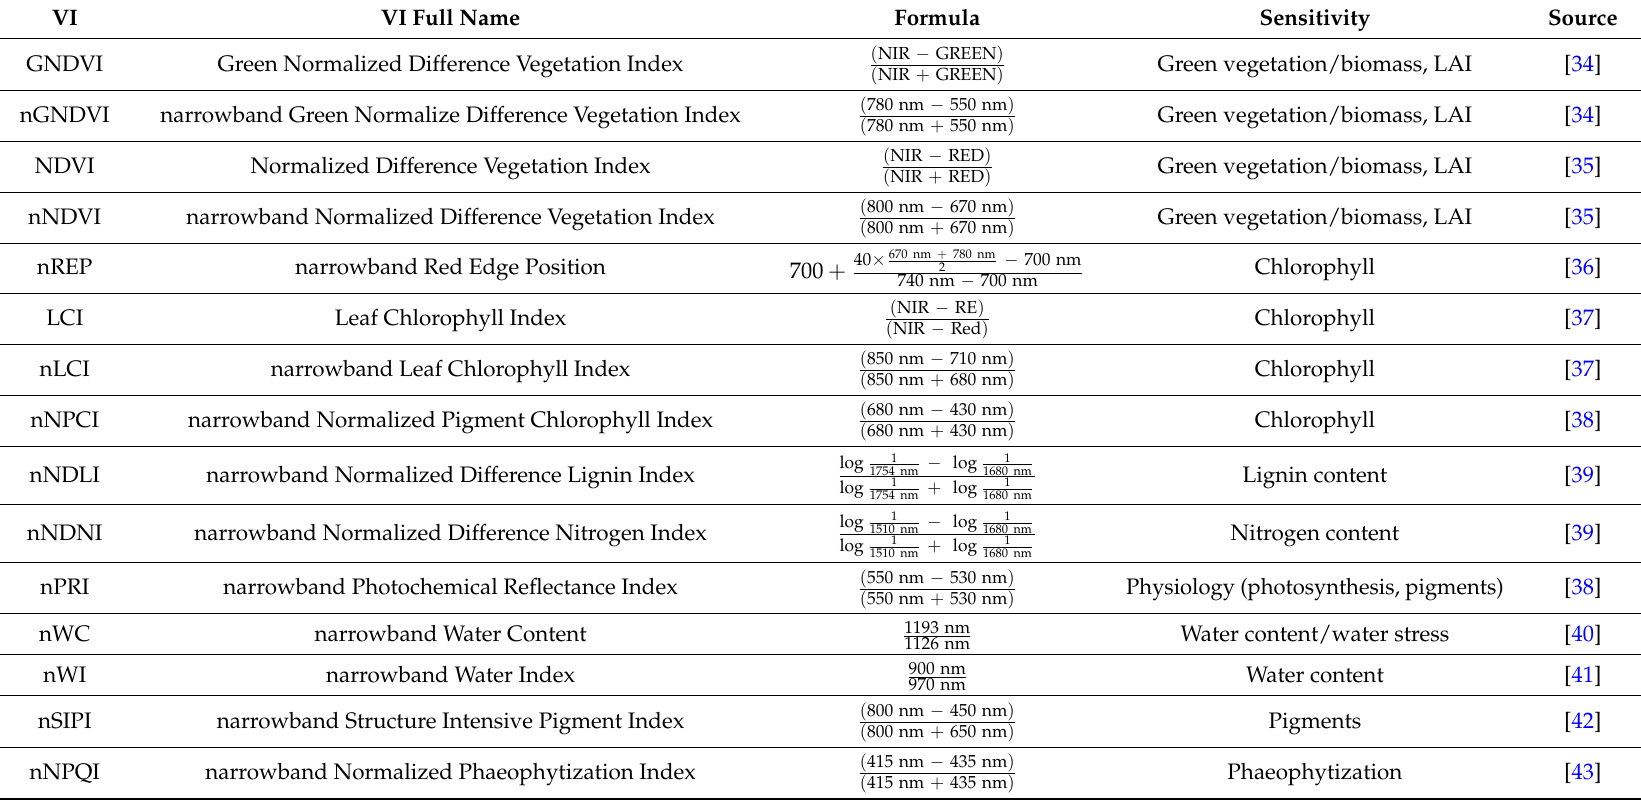
Table 2. Selected VIs for discriminating differently-fertilized grassland